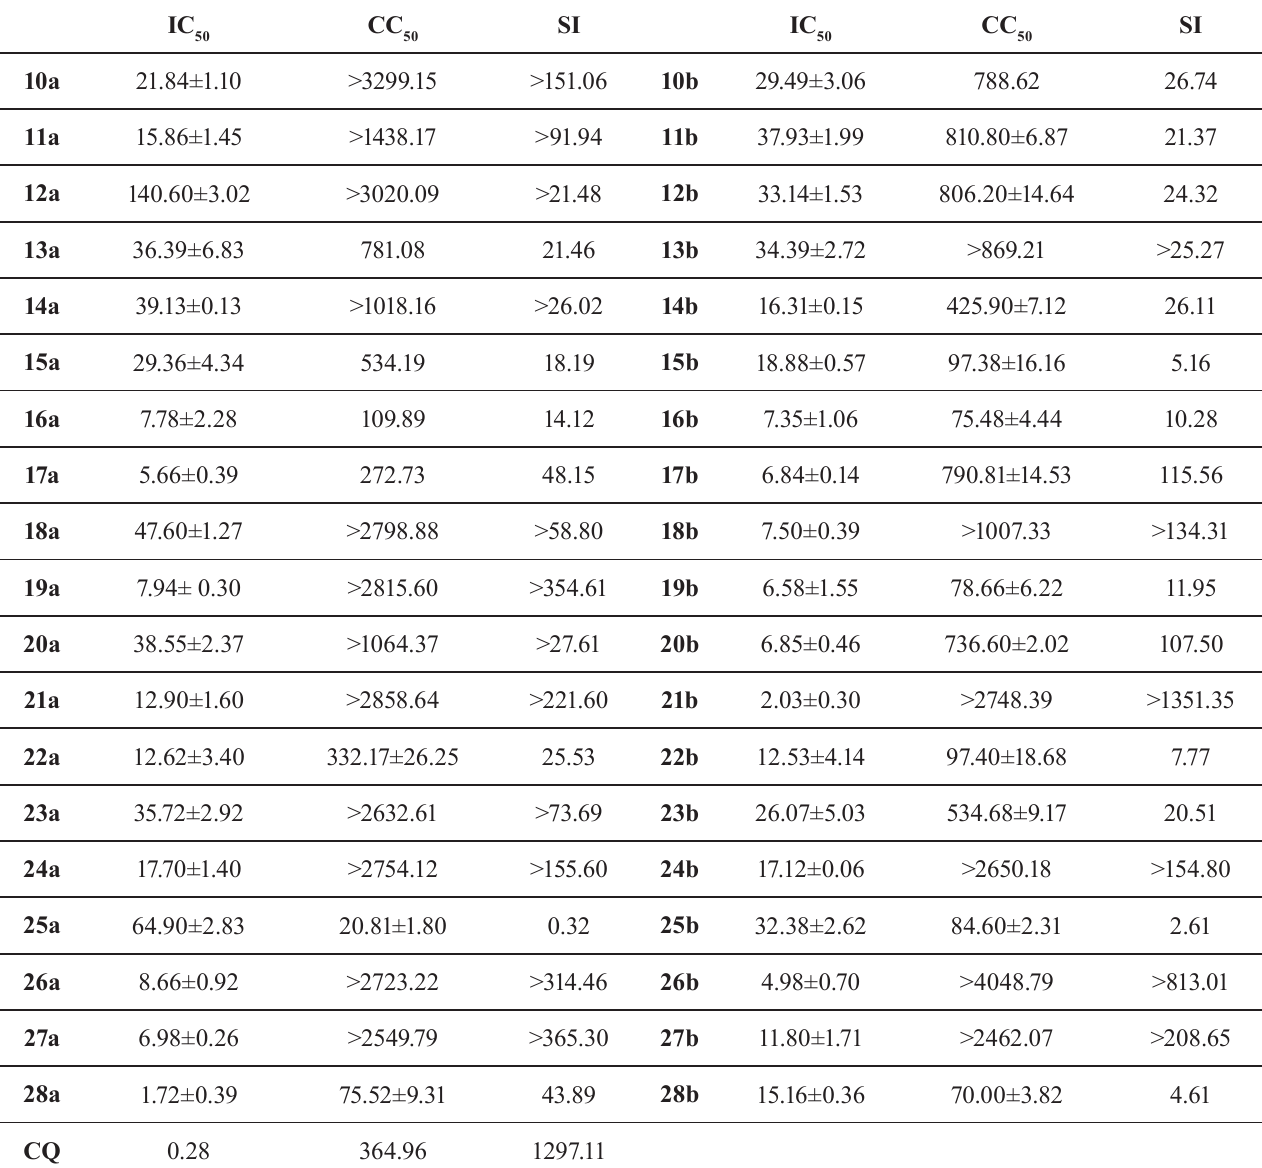
TABLE I – Q uinolinotriazole products 10-28, in vitro antimalarial activity (IC50 µM) against P. falciparum (W2 clone), cytotoxicity (CC50 µM, Hep G2A16 cells) and selectivity index